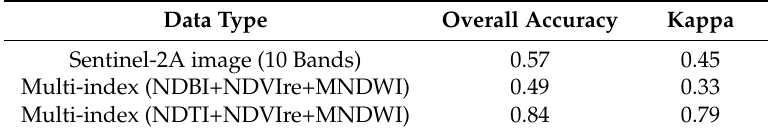
Table 9. Comparison of the overall accuracy and Kappa statistics for the Konya